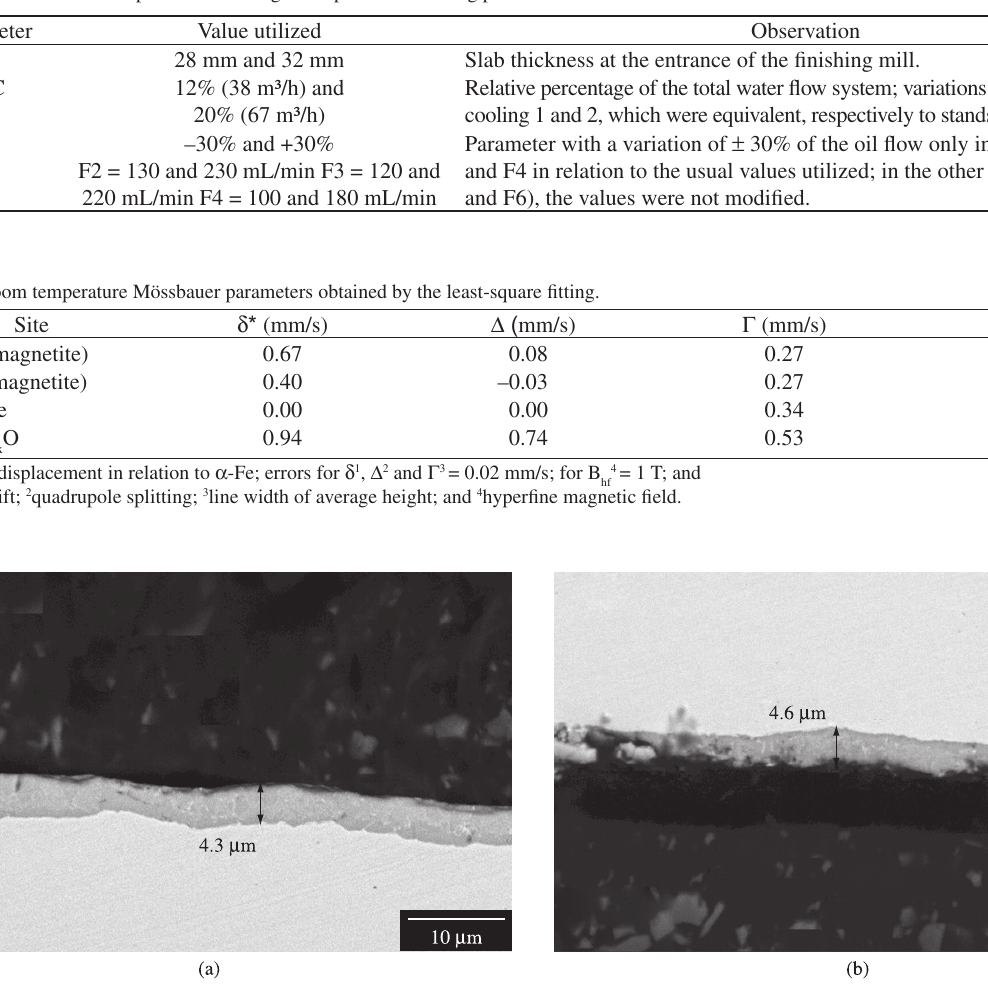
Figure 1. Image of a cross section of the A3 sample (ISC at 12%; oil flow at +30%; slab thickness = 32 mm) in SEM. a) surface top; and b) surface